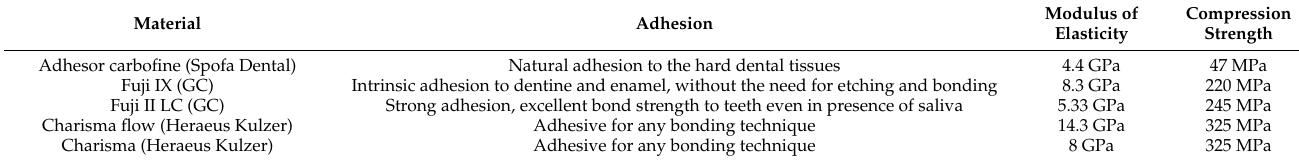
Table 1. Data regarding adhesion to the dental structures, elasticity modulus and compression strength. Material Adhesion Modulus of Elasticity Compression Strength Adhesor carbofine (Spofa Dental) Natural adhesion to the hard dental tissues 4.4 GPa Intrinsic adhesion to dentine and enamel, without the need for etching and bonding Strong adhesion, excellent bond strength to teeth even in presence of saliva Adhesive for any bonding technique Adhesive for any bonding